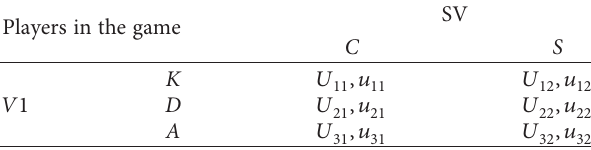
Table 1: Lane-changing game payoff matrix. Players in the